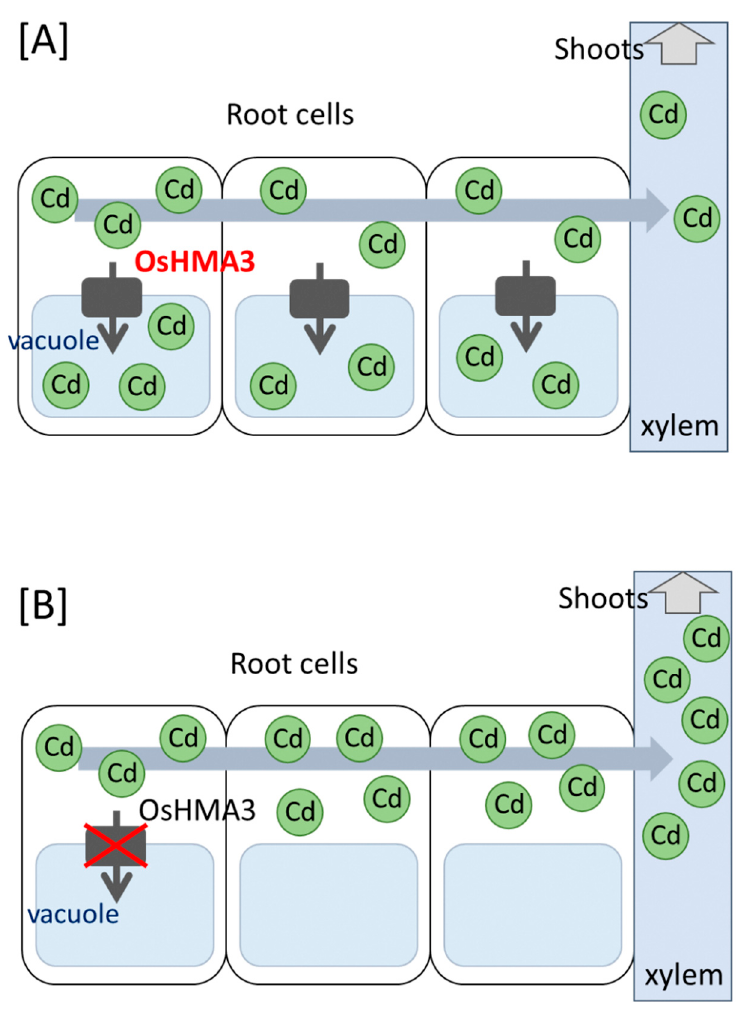
Figure 1. Proposed model for the role of OsHMA3 in Cd translocation from the roots to the shoots. The Cd is sequestered into the vacuole via OsHMA3 in normal varieties ( A ), whereas not in high Cd-accumulating varieties ( B ). The remaining Cd in the cytoplasm is loaded into the xylem.